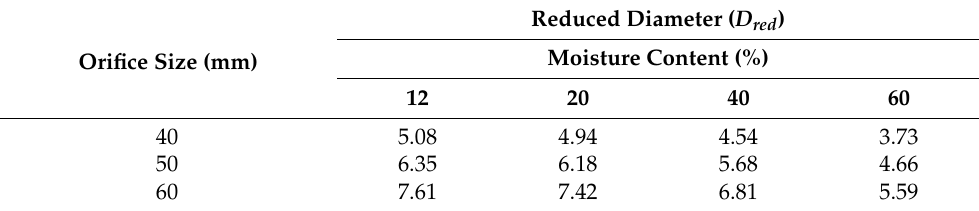
Table 4. Reduced diameter at different moisture content for different orifice